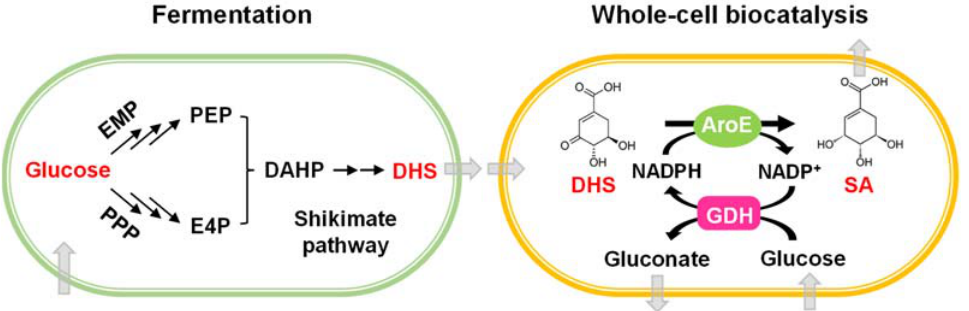
Figure 1. Simple diagram of the relay-race synthesis of SA from glucose by coupling microbial fermentation with whole-cell biocatalysis. EMP, Embden-Meyerhof-Parnas pathway; PPP, pentose phosphate pathway; PEP, phosphoenolpyruvate; E4P, D-erythrose 4-phosphate; DAHP, 3-deoxy-D-arabino-heptulosonate-7-phosphate; DHS, 3-dehydroshikimic acid; SA, Shikimic acid; AroE, shikimate dehydrogenase; GDH, glucose dehydrogenase.